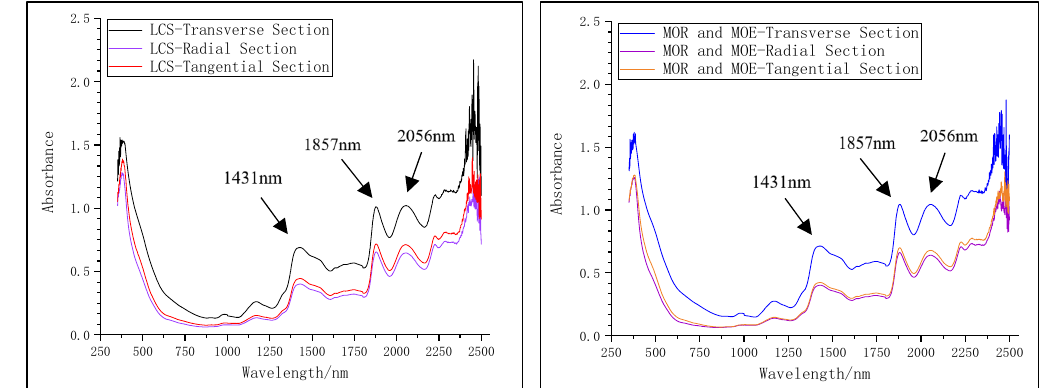
Figure 3. Three sections of spectra of mechanical testing pieces.